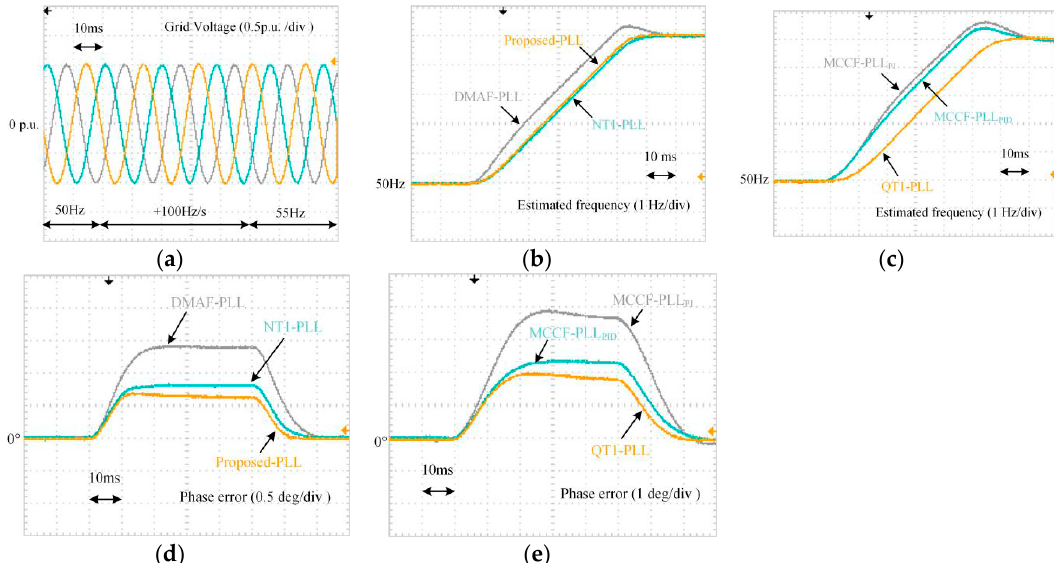
Figure 23. Experimental waveforms under a +100 Hz/s frequency ramp change: ( a ) Three-phase voltages; ( b , c ) Estimated frequency; ( d , e ) Phase error.